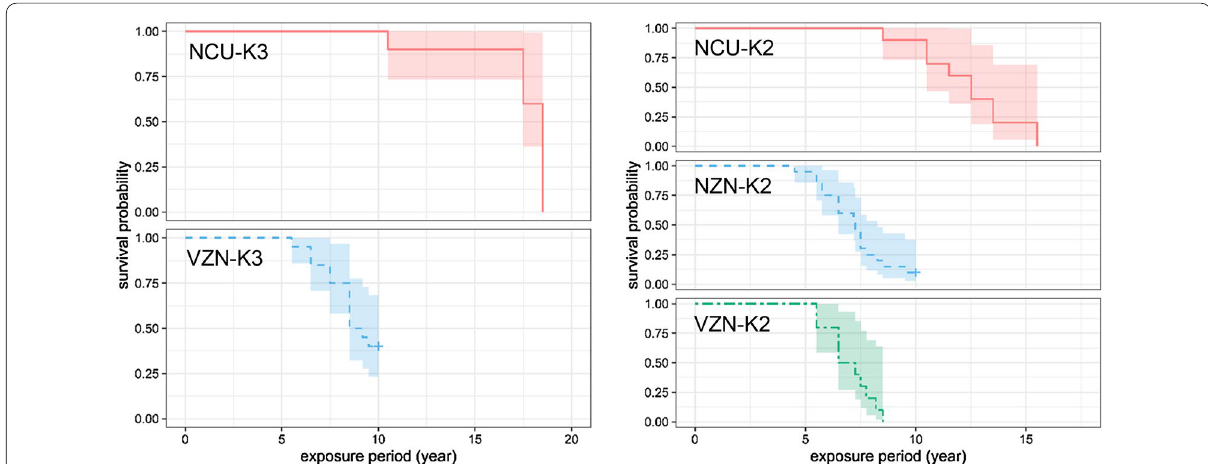
Fig. 3 Kaplan–Meier curves for stakes impregnated with emulsified preservative. Left: stakes impregnated with preservatives at K3 performance classification. Right: stakes impregnated with preservatives at K2 performance classification. Information on the stakes in each performance classification is shown in Table